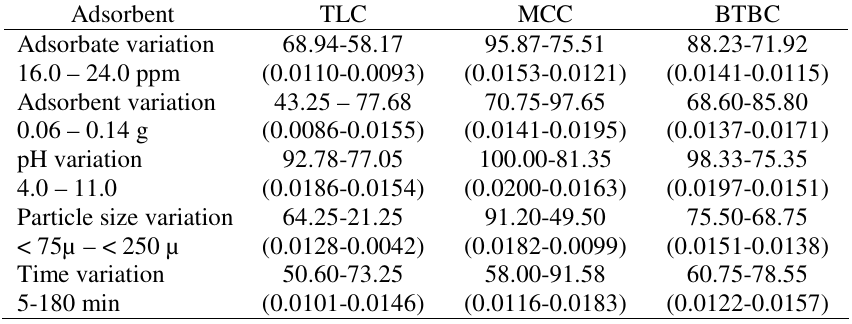
Table 1. Extent of removal of dye by TLC, MCC and BTBC at 30 + 1 o